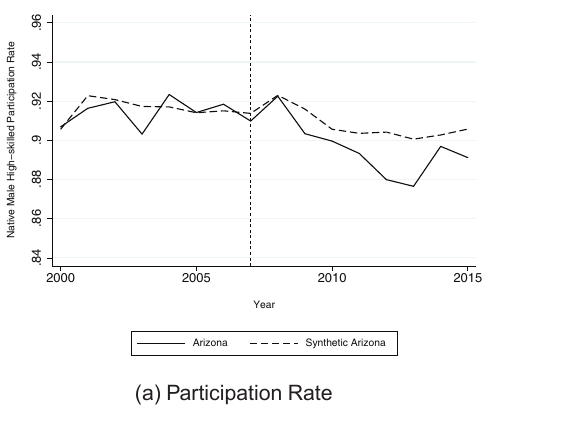
Figure A19 Native high-skilled male participation rate